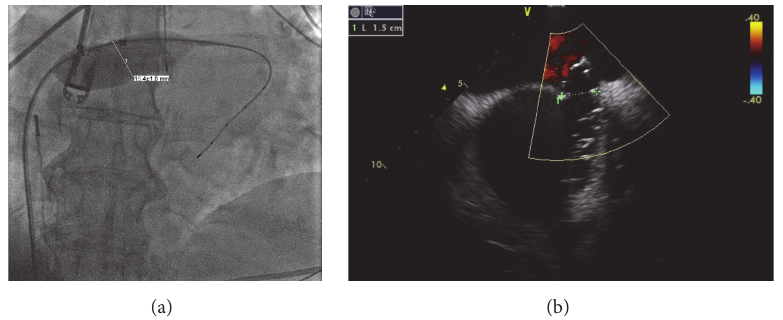
Figure 1: (a) Sizing balloon showing the diameter of the ASD. (b) Intracardiac echocardiogram showing the diameter of the ASD.